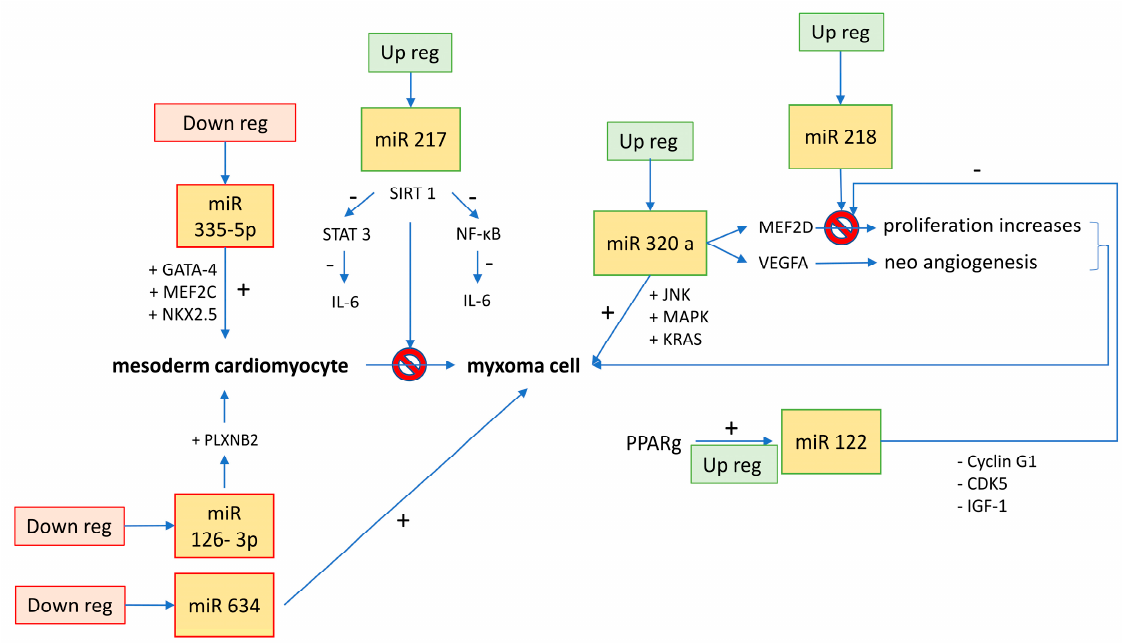
Figure 1. Regulation of miRNAs in cell differentiation from stem cells to myxoma cells.